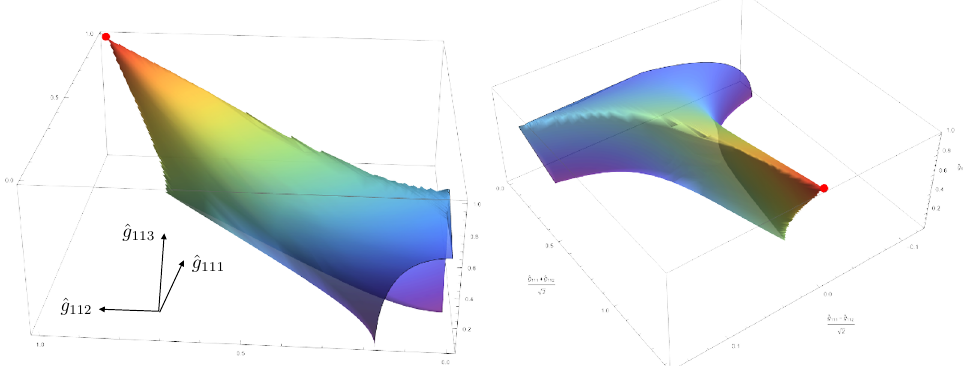
Figure 7 . Left: maximum couplings g 11 j for a theory with the masses of the Ising field theory deformed by magnetic field depicted by normalizing those by the Ising couplings, ˆ g 11 j ≡ g 11 j /g Ising at this E 8 point. Right: the plot on the right is obtained by a simple rotation of the first by 45 degrees which magnify some of the nice features of the plot. (These plots were generated using the dual method developed in this paper with N = 20 ; it might be possible to derive this shape analytically. We did it for one of the faces but did not pursue this further.) The Ising field theory, the red dot, lies beautifully at the very tip of these horn shaped single component